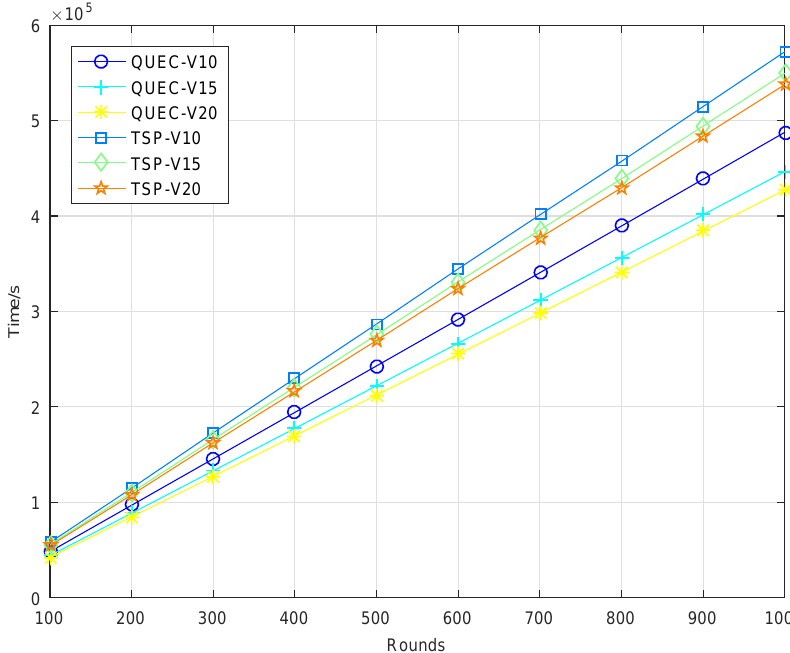
Figure 5. Time required to complete the coverage